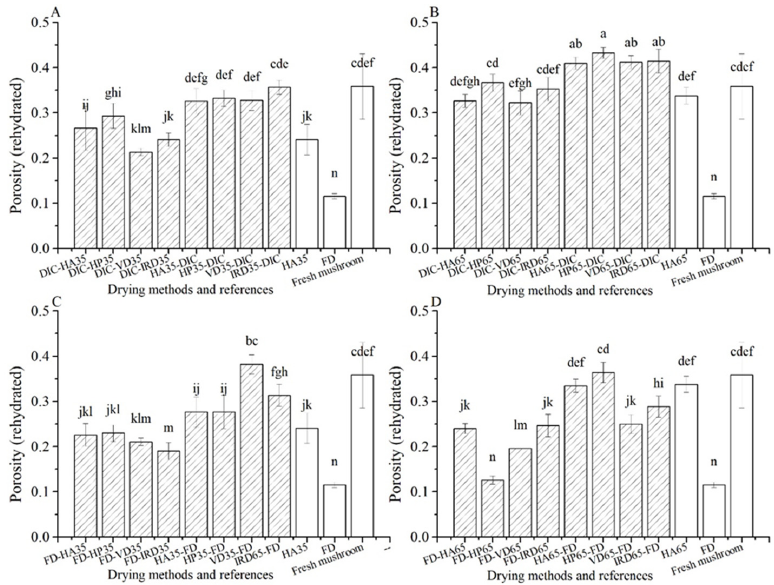
Figure 2. Volume recovery ratio of mushrooms after rehydration with different drying methods (